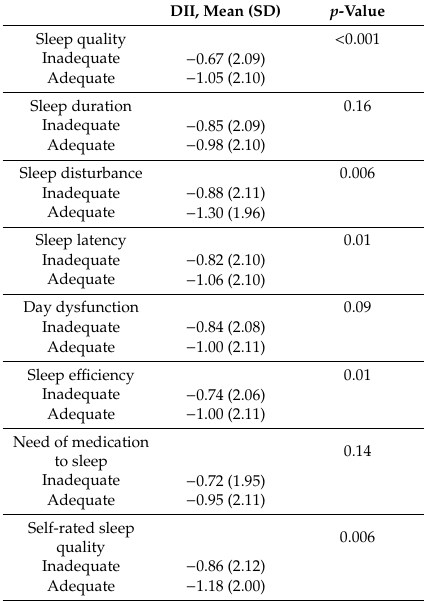
Table 3. Mean scores (and standard deviation) of Dietary Inflammatory Index (DII) by